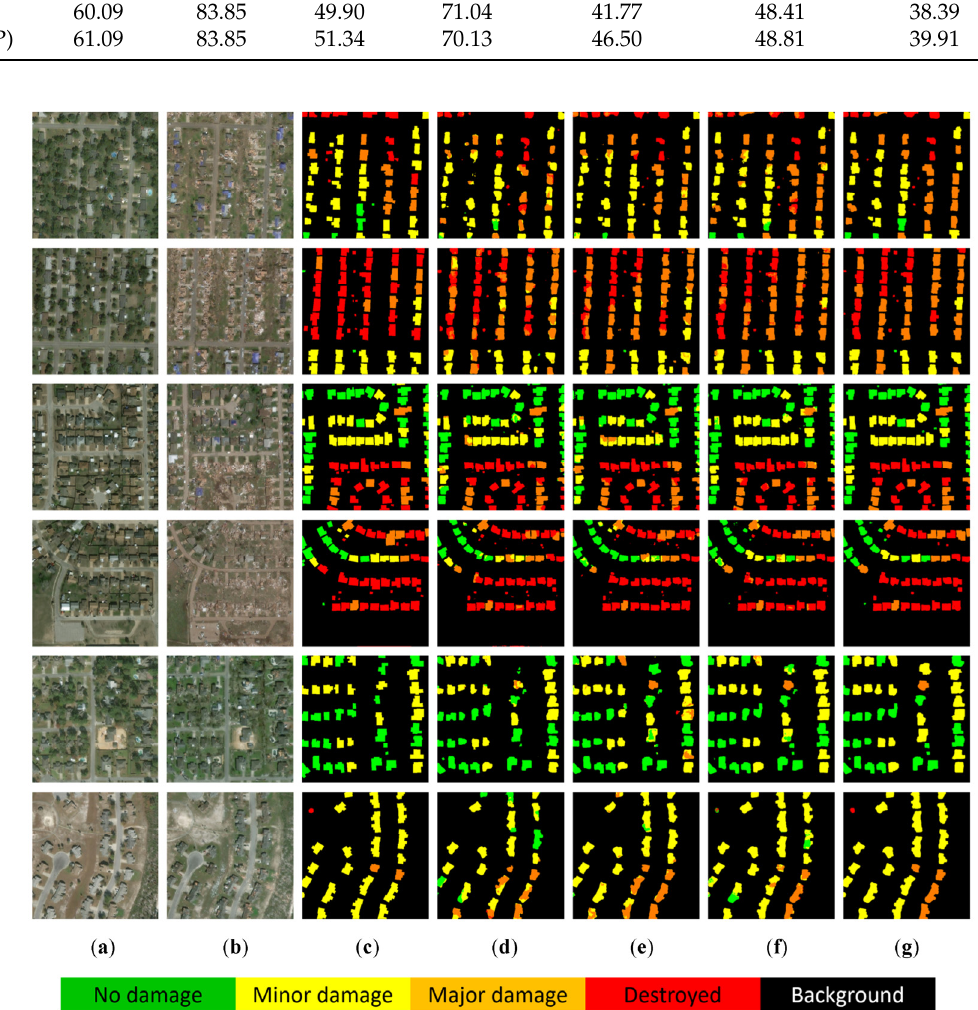
Figure 6. Visual comparison of different SL methods on three datasets. ( a ) Pre-disaster image, ( b ) post-disaster image, ( c ) ground truth, ( d ) Siamese U-Net, ( e ) BDANet, ( f ) ours (MT), and ( g ) ours (MT + PP).